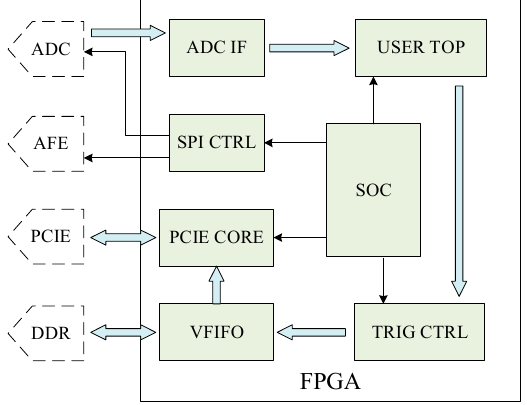
Figure 6. The internal logic interface diagram of FPGA.